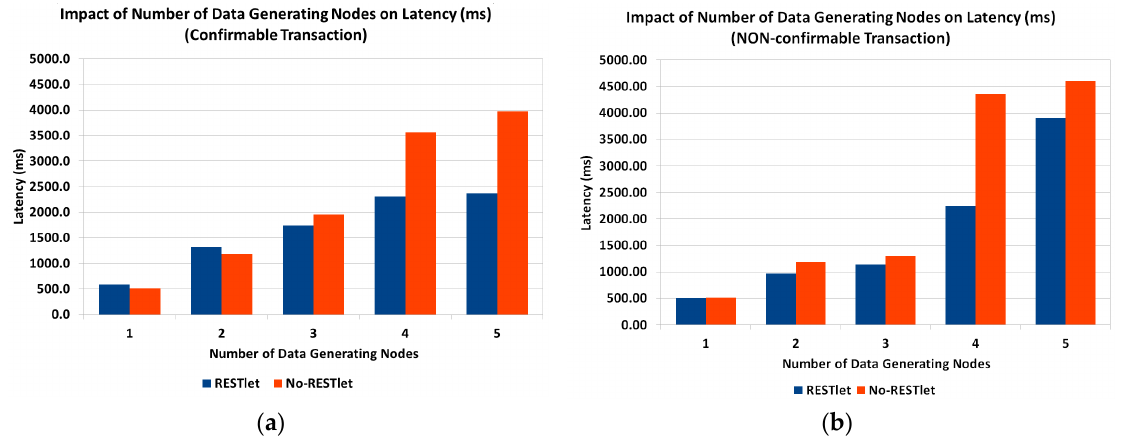
Figure 20. Impact of Number of Data Generating Nodes on End-to-End Latency. ( a ) Confirmable Communication; ( b ) NON-Confirmable Communication.